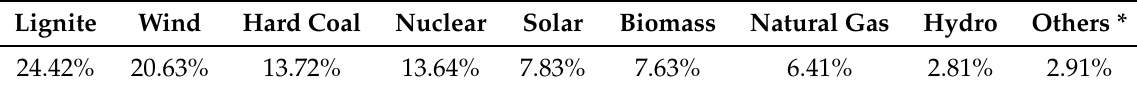
Table 5. Percentage of resources used during peak and off-peak hours in Germany [51].